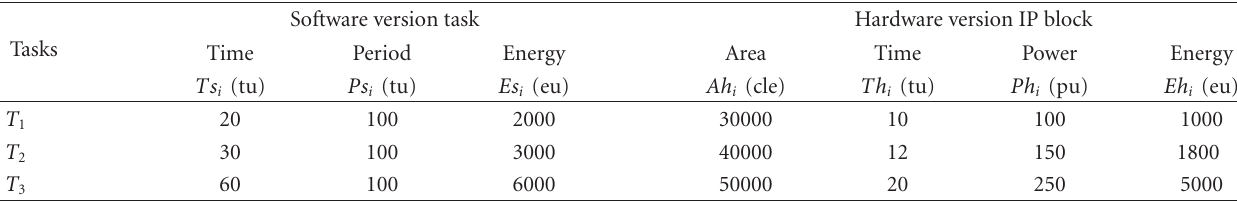
Table 1: Task characteristics for design exploration based on AADL description. The average power of the processor is supposed to be independent from the executed task and equals to Pp = 100pu (power unit).